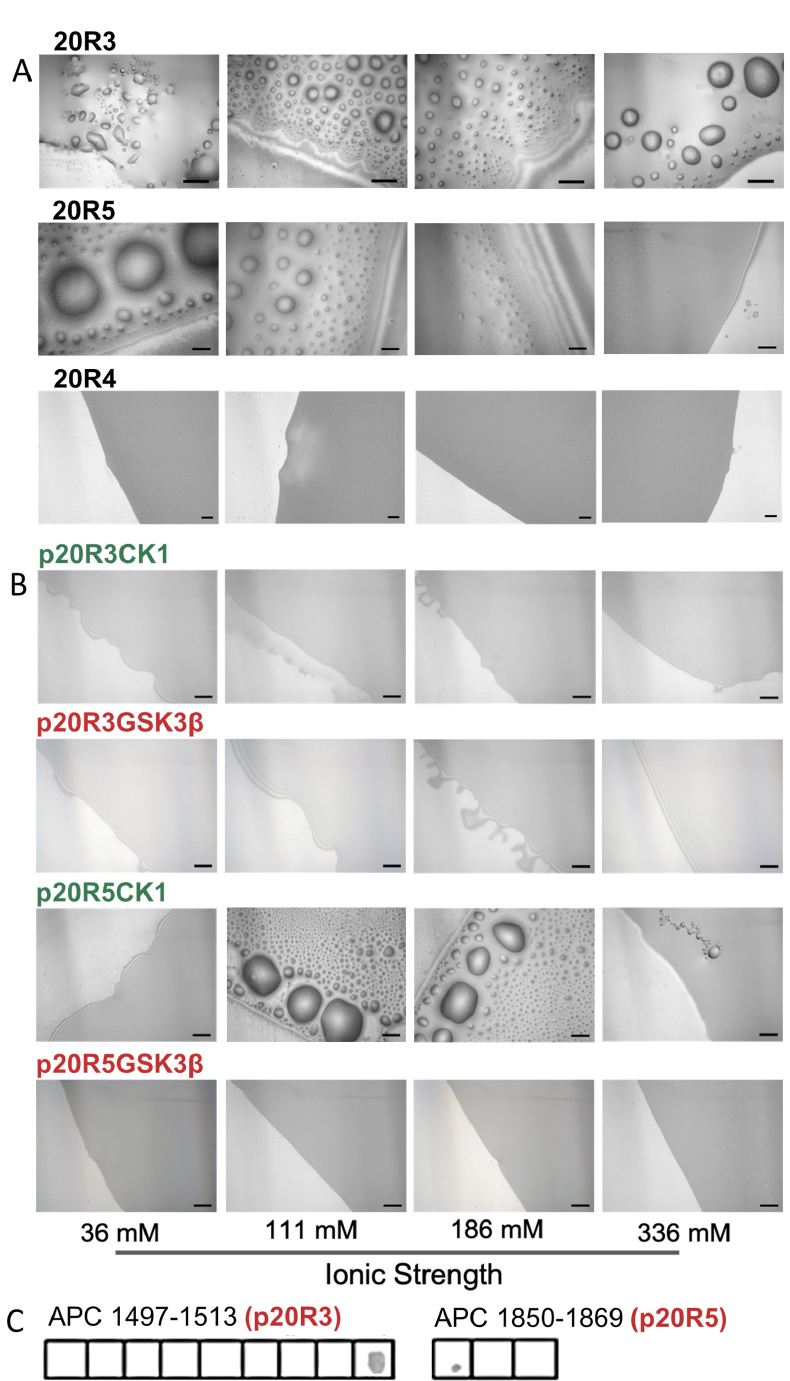
(336 mM), it did not form droplets. The p20R3CK1 peptide did not form droplets at any ionic strength.